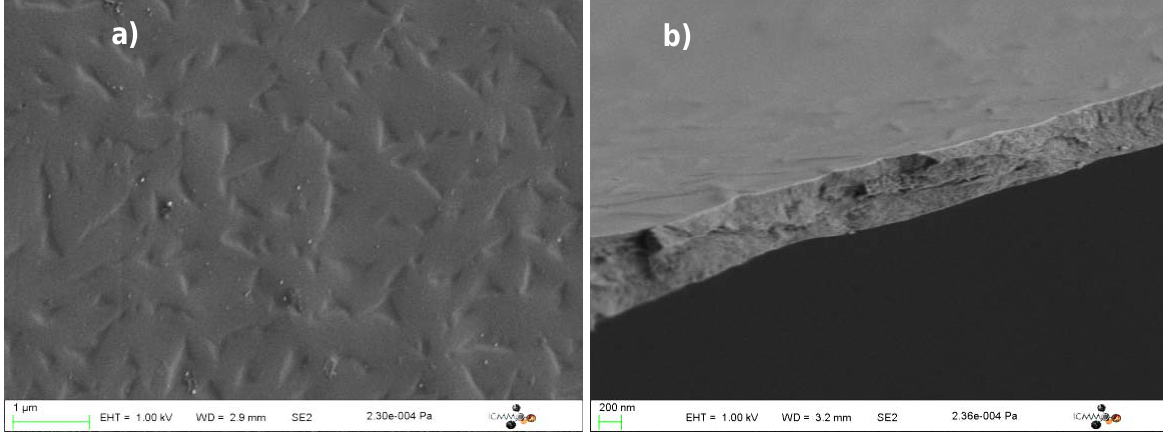
Figure 11. Scanning electron microscopy (SEM) micrographs of the calcined Co(II)-containing silica films: ( a ) Top-view; ( b ) Side-view. a)